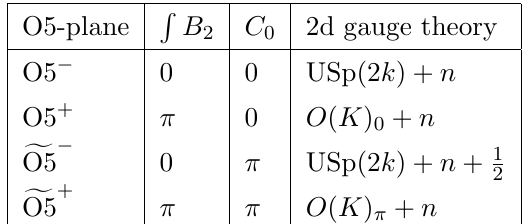
Table 4 . The four versions of the orientifold 5-plane and the corresponding D1-brane theories. vanishing (cid:12)eld strength, C